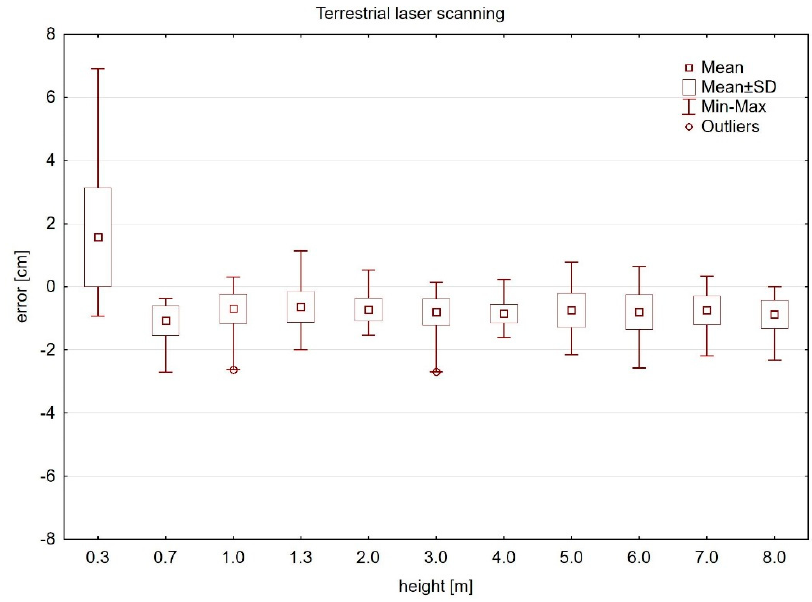
Figure 5. Diameter estimation errors in TLS point cloud cross sections.